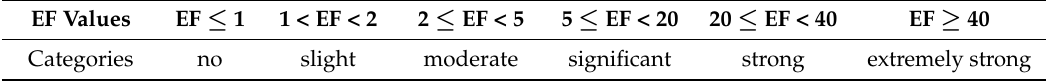
Table 1. Contamination categories on the basis of enrichment